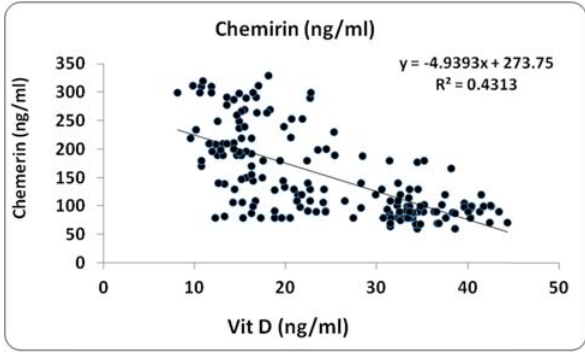
Figure 5: Scatter plot with regression line between vitamin D and